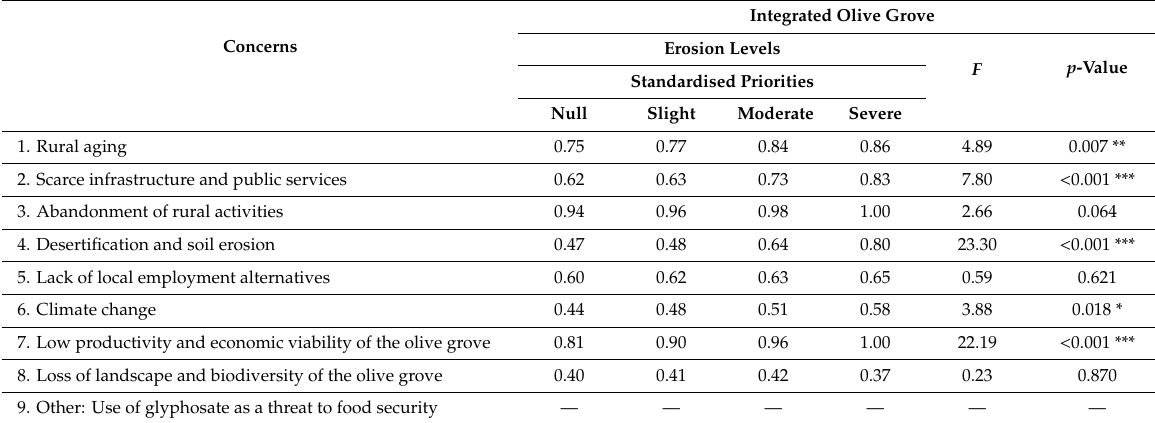
Table 8. Standardised priorities for the main concerns in the olive groves with integrated management within their erosive levels in Estepa region. Statistical values of F (Kruskal–Wallis test) and p -values; significant ( < 0.05 *), very significant ( < 0.01 **), and highly significant ( < 0.001 ***) are